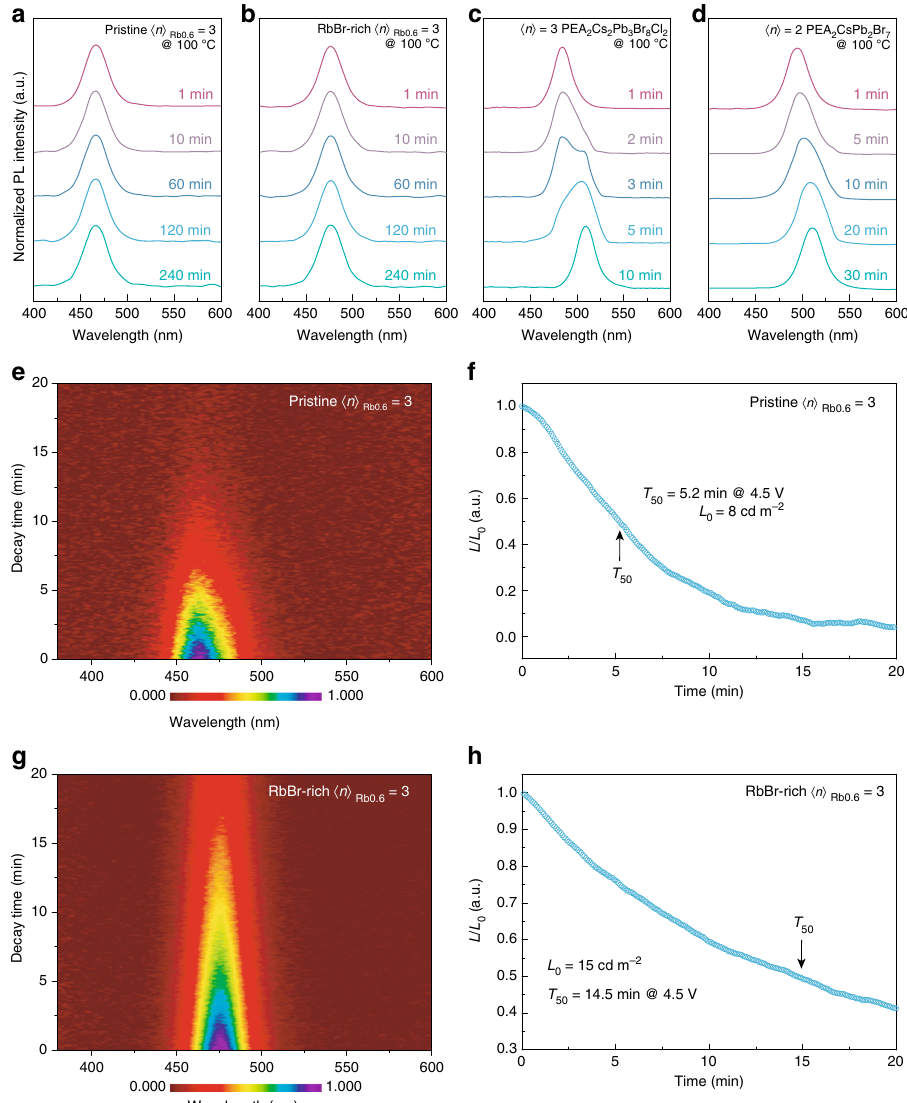
Fig. 5 Spectral stability measurements. PL spectra evolution of ( a ) pristine < n > Rb0.6 = 3, ( b ) RbBr-rich < n > Rb0.6 = 3, ( c ) < n > = 3 mixed-halide PEA 2 Cs 2 Pb 3 Br 8 Cl 2 , and ( d ) lower-dimensional < n > = 2 PEA 2 CsPb 2 Br 7 perovskites after continuous thermal treatment (100 ℃ ) for different times. e , g The EL spectra change under constant voltage of 4.5 V. Lifetime measurement ( T 50 ) of the ( f ) pristine and ( h ) RbBr-rich < n > Rb0.6 = 3 PeLED device at a constant voltage of 4.5